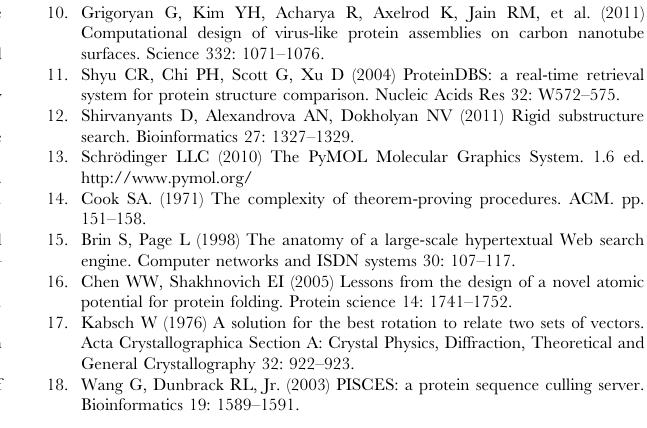
Table S3 Results for throughput benchmarks. (Search) The matching column from Figure 8. (Figure # ) The figure the search corresponds to. (Search # ) The order of searches used to build the structure depicted in the figure (See Table S2). ( # of atoms) The number of atoms in the search query. (Time) The elapsed time from query submission to final result retrieval. (Matches) The number of matched results returned by the search engine. (Structures/second) The throughput of the search engine, defined as (Time/Models indexed). Manual S1 User instructions. These instructions provide detailed guidance on how to use all three software packages (Software S1, S2,